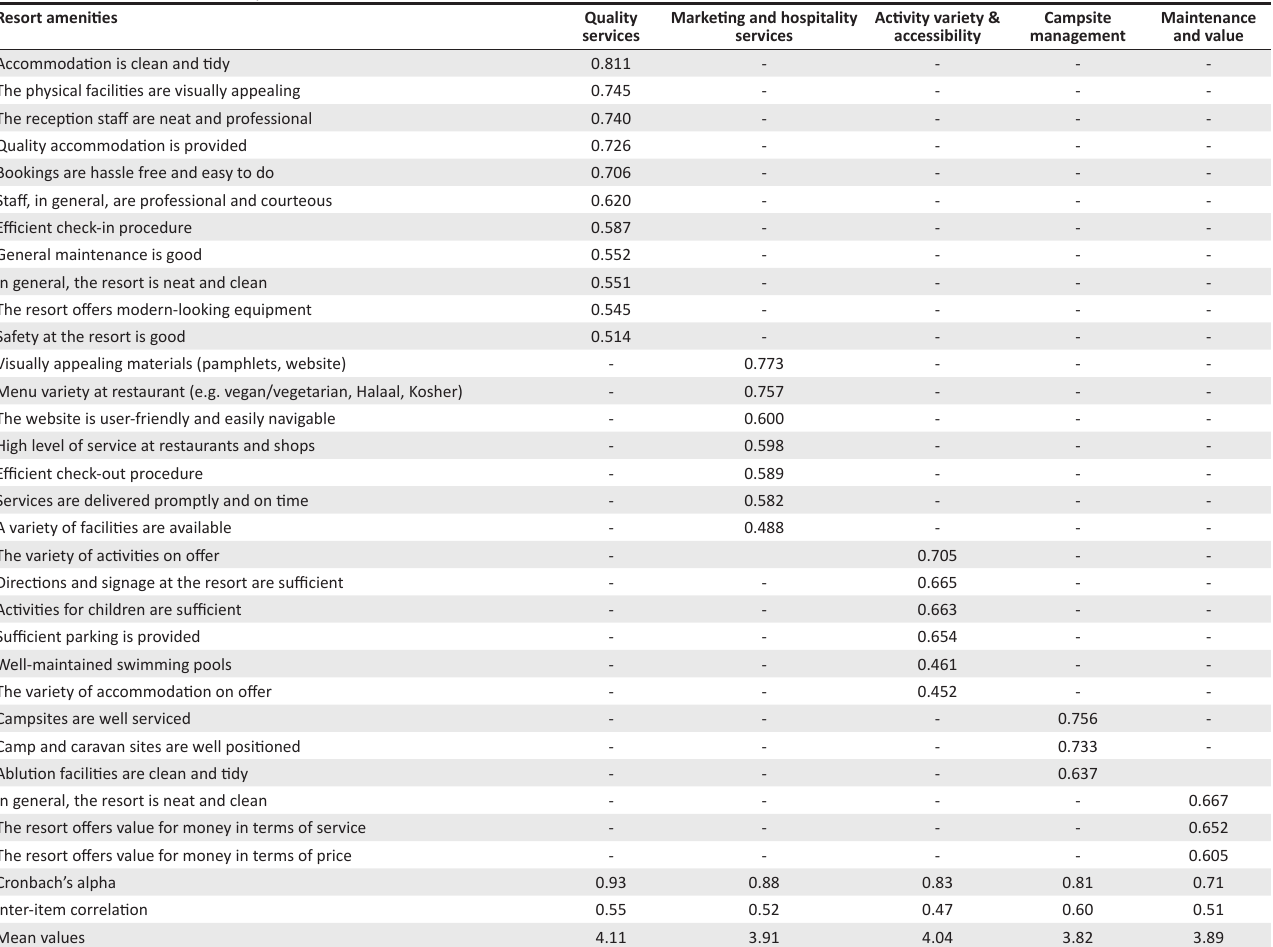
TABLE 5: Results of the factor analysis on resort